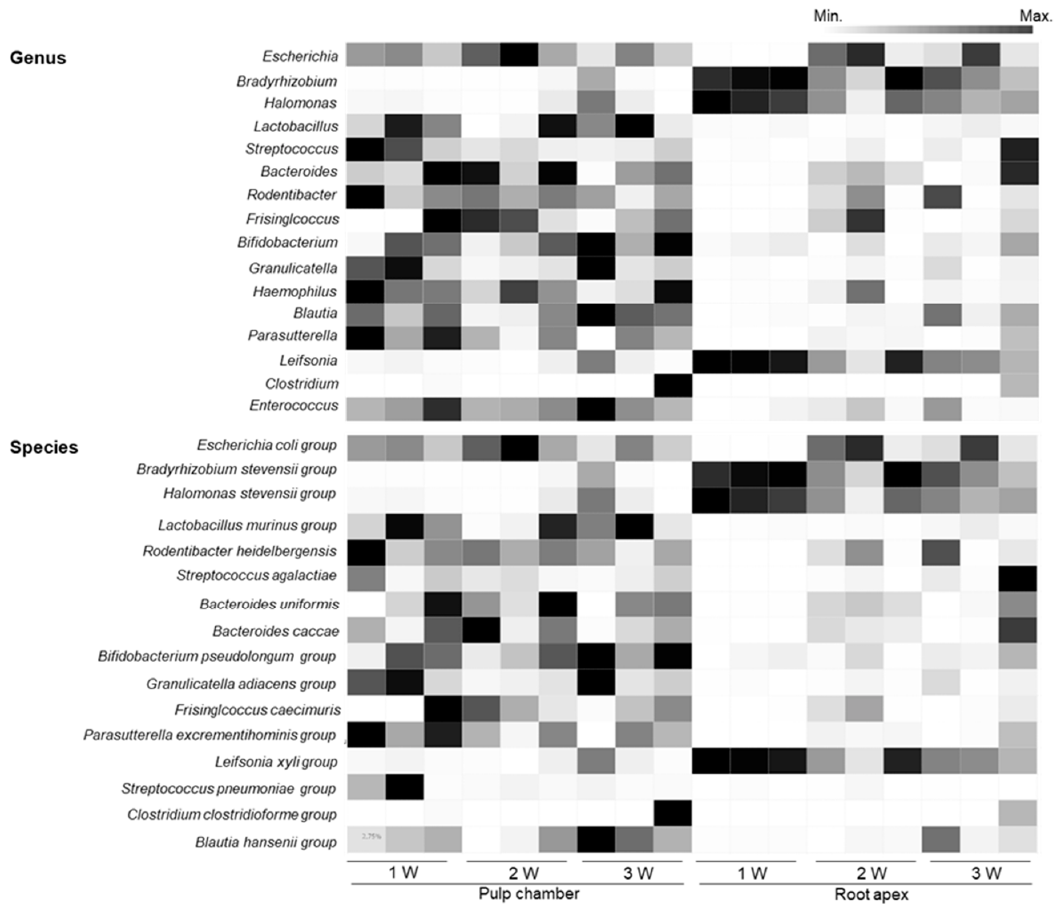
Figure 5. Heat map of the relative abundance of bacterial genera and species identified in the pulp chamber and the root apex. Any phylotype spanning more than 1% in at least one individual sample tested was included in the representative species. Colors reflect relative abundance from low (white) to high (black).